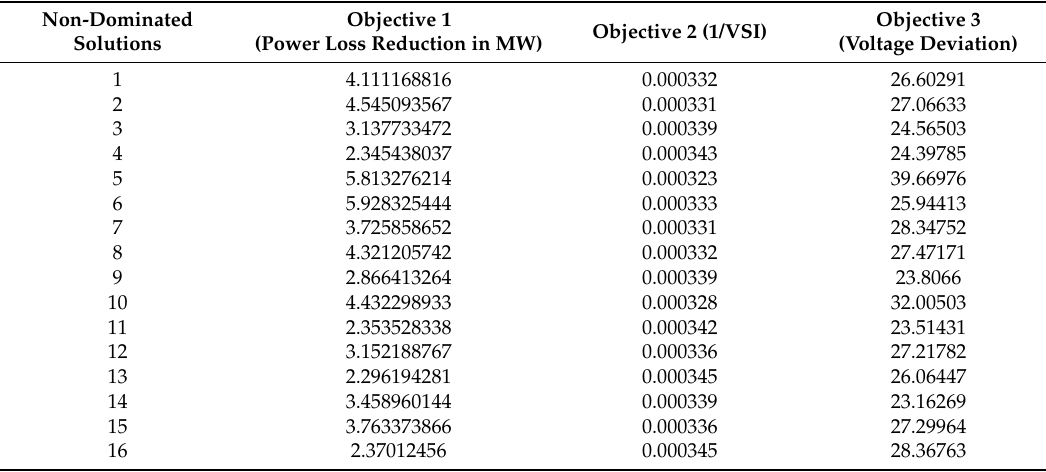
Table A2. Non-dominated solution set of MOPSO obtained after installation of renewable DGs and capacitor